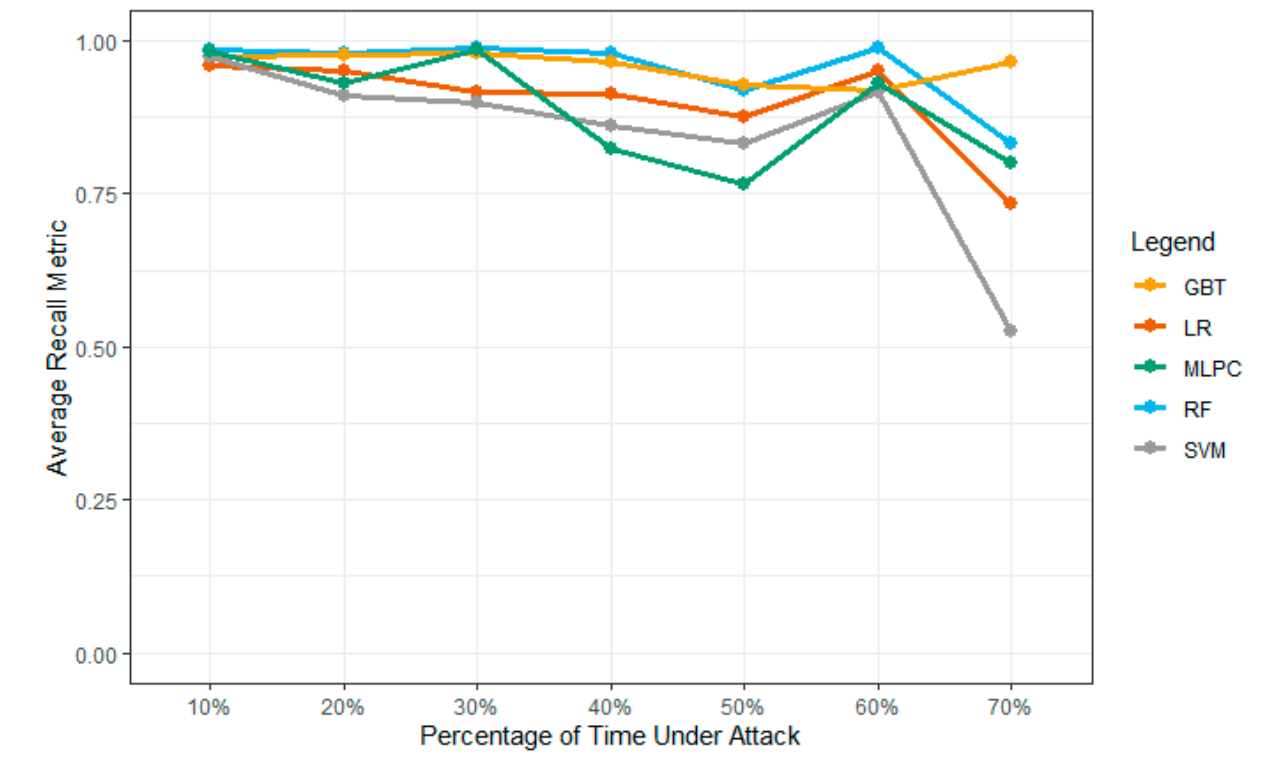
Figure 16. Comparison of model recall values over the network performance.